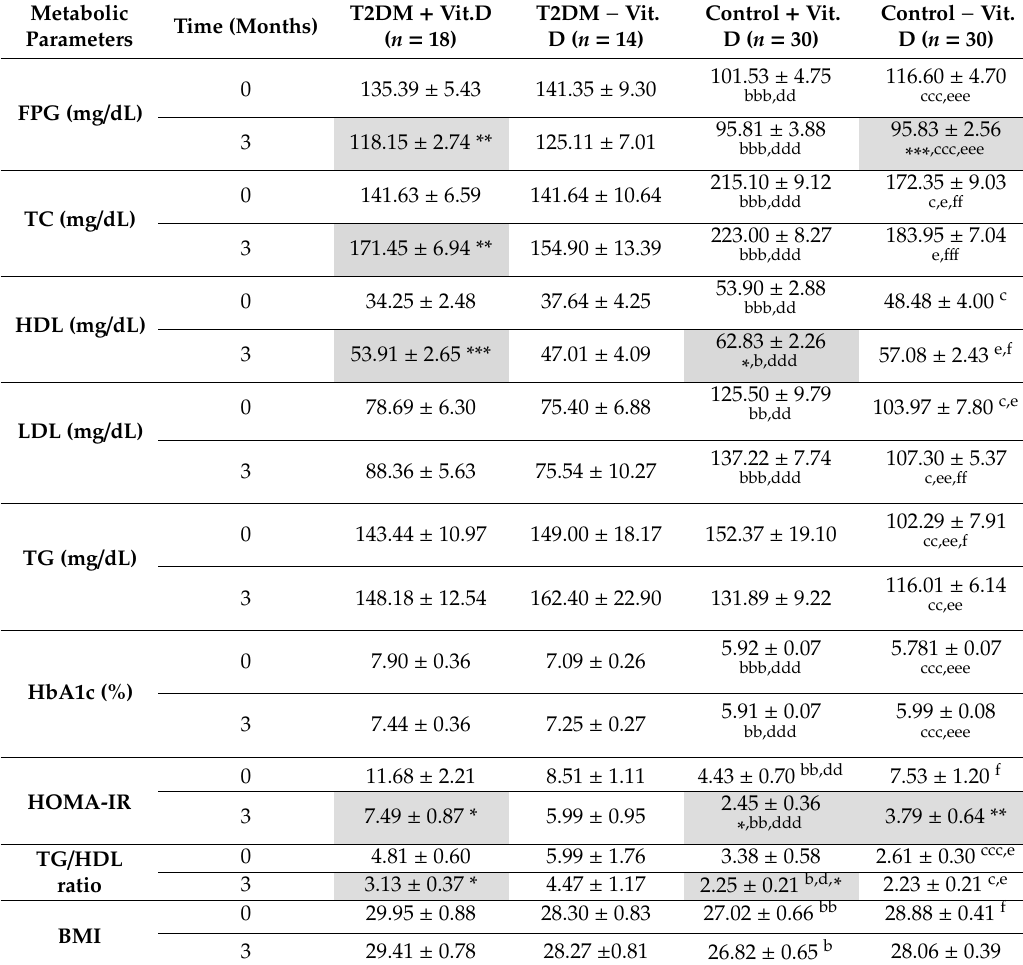
Table 2. Metabolic parameters of patients with T2DM (T2DM + Vit. D, n = 18; T2DM – Vit. D, n = 14) and patients without T2DM (Control + Vit. D, n = 30; Control − Vit. D, n = 30) at baseline (0)